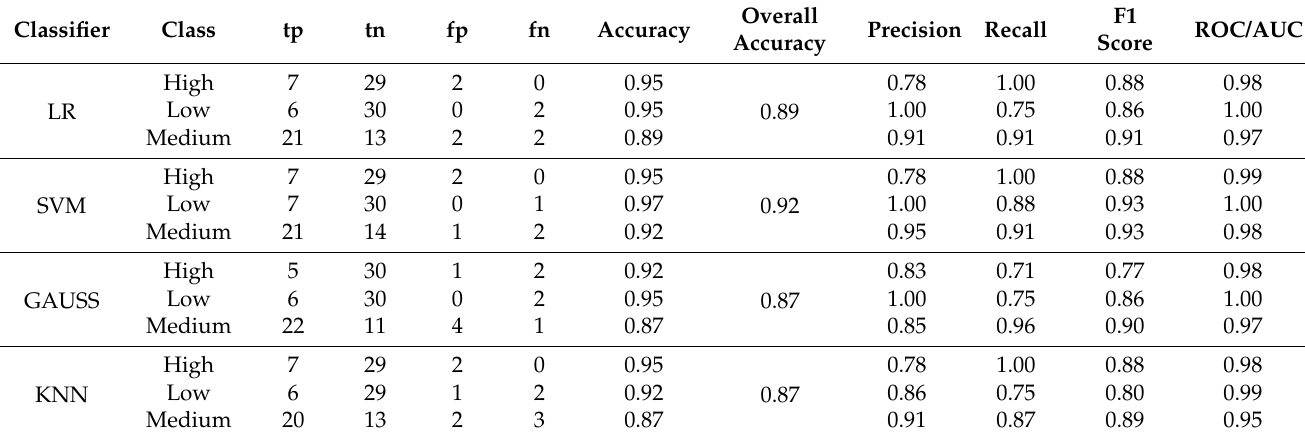
Table 15. Set of metrics of the balanced models (testing